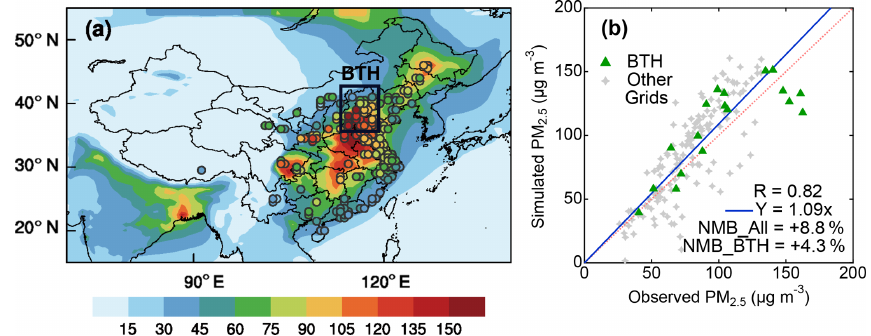
Figure 2. (a) Spatial distributions of simulated (CTRL, shades) and observed (CNEMC, dots) seasonal (DJF) mean surface-layer PM 2 . 5 con- centrations (µgm − 3 ) averaged over five winters (2013–2017). (b) Scatterplot of simulated versus observed DJF mean PM 2 . 5 concentration (µgm − 3 ) averaged from 2013 to 2017 for 161 grids in (a) , where the green grids are 18 grids located in the BTH (Beijing–Tianjin–Hebei) region. Also shown in (b) are the y = x line (dashed), linear fit (solid line and equation), and values of r and NMB. Here, r is the correlation coefficient between simulated and observed PM 2 . 5 concentrations. NMB ( normalized mean bias ) = ( P N where O i and M i are the observed and simulated PM 2 . 5 concentrations, respectively. i refers to the i th site, and N is the total number of sites.